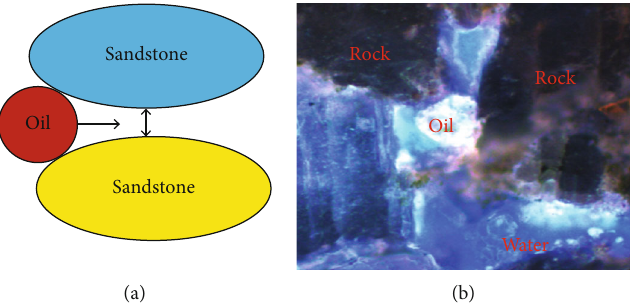
Figure 20: Reasons for formation of residual oil via Jia Min e ff ect. (a) Schematic. (b) Fluorescent picture.